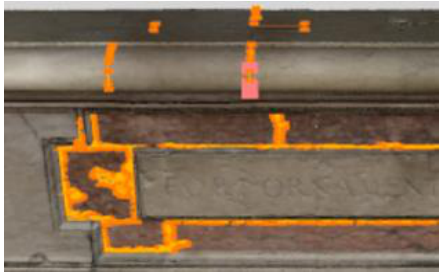
Figure 13. An example of the mapping of damaged areas, by means of direct identification and sketch on the 3D model of the